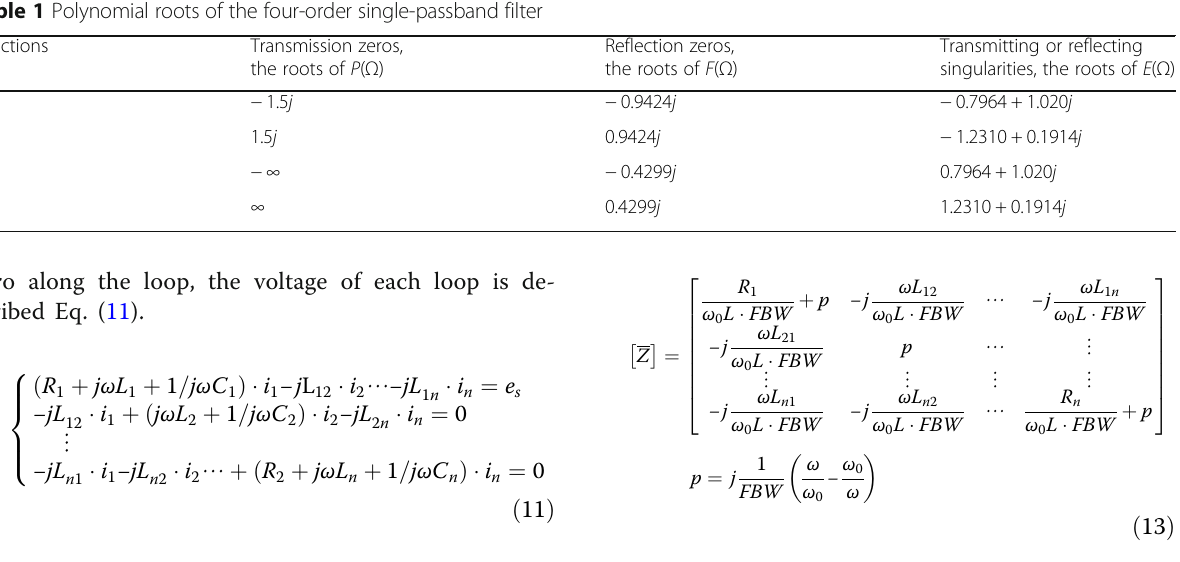
Transmitting or reflecting singularities, the roots of E ( Ω )